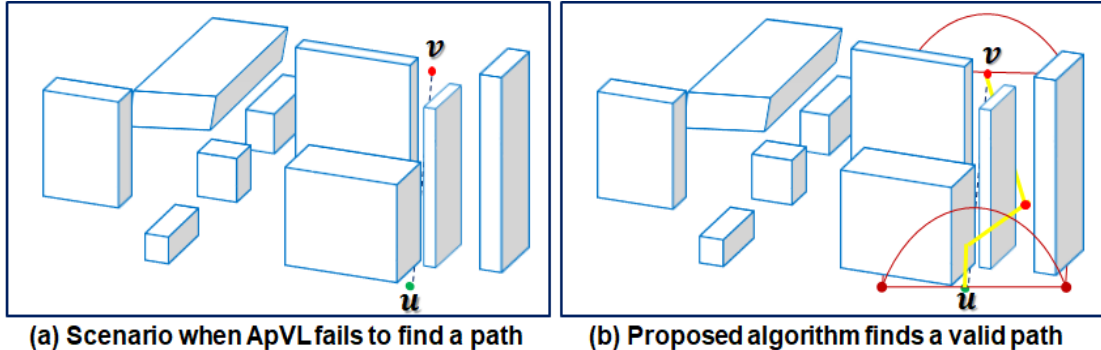
Figure 10. Path guarantees test: Proposed algorithm versus ApVL